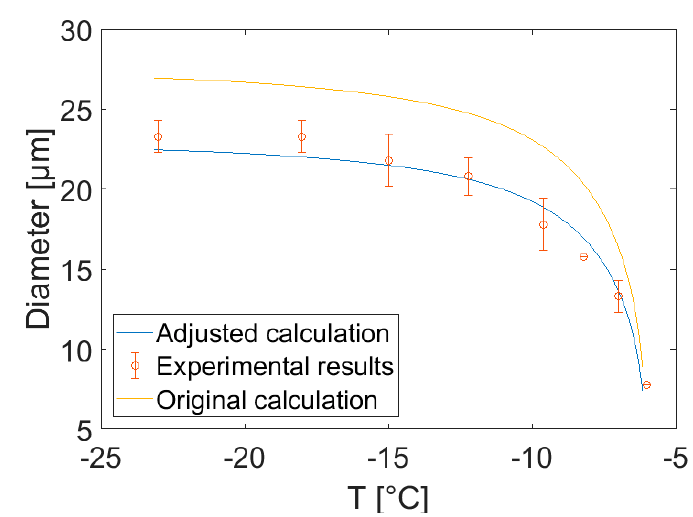
Figure 8. The diameter of ice crystals (modal values obtained from the 3D accessible volume method) measured from in situ sCT data (orange circles), compared with the diameter predicted by the present numerical model (solid blue line, the adjusted calculation; solid yellow line, the original calculation). Model diameter is calculated as D 3,0 For the calculations, we used the water and sucrose fractions f w 0 = 0.55 and f s = 0.29 respectively. Error bars correspond to the range of the modal values.